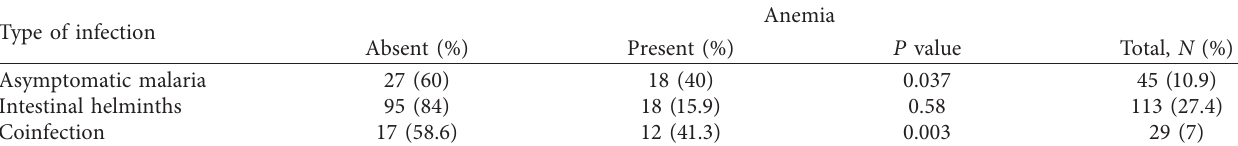
Table 7: Prevalence of anemia among asymptomatic malaria, helminths, and coinfected primary school children in Gedeo zone, Southern Ethiopia. Type of